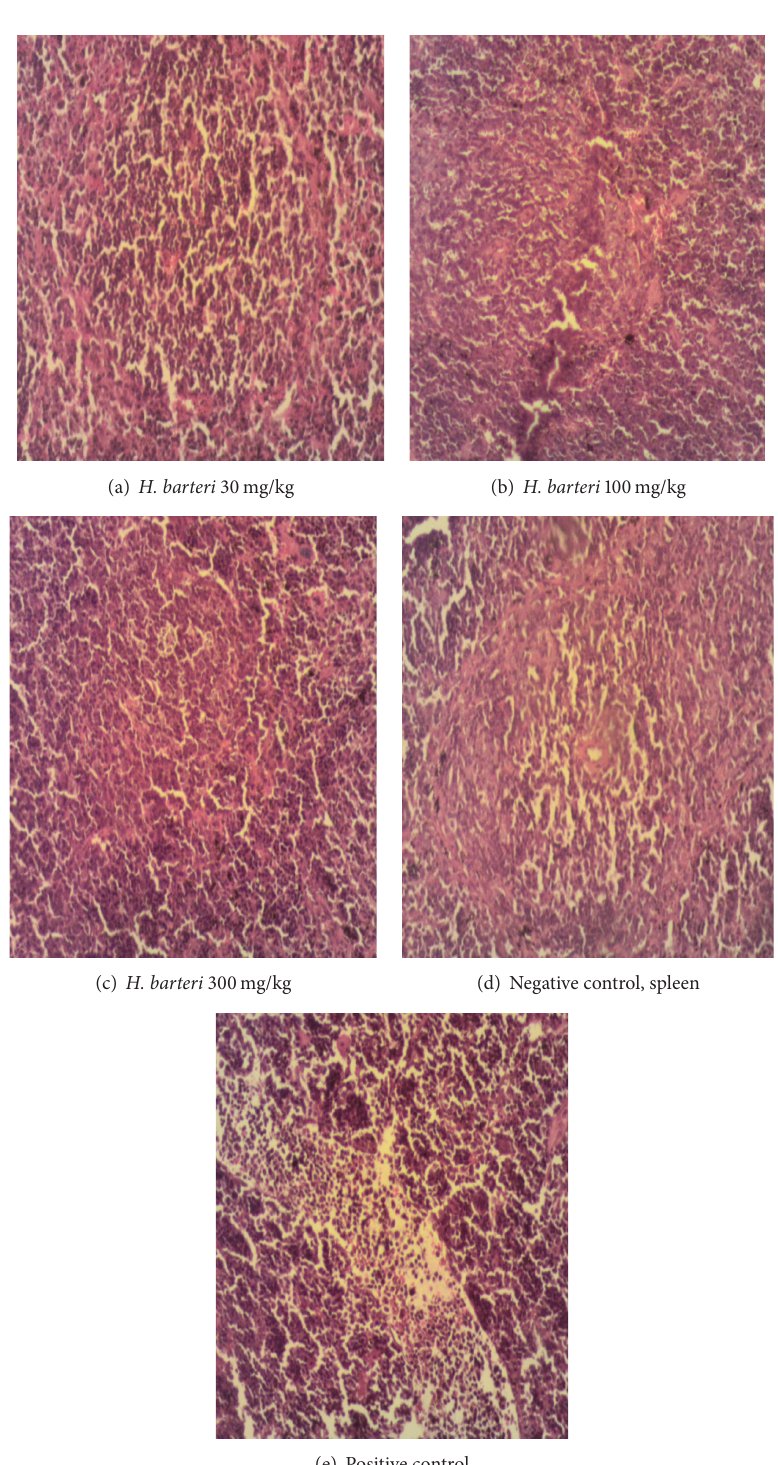
Figure 4: Sections of spleen under high magnification (100x). (a) H. barteri (30mg/kg), extract treated spleen: mild reduction of these pathologies caused by the parasite in the tissues; (b) H. barteri (100mg/kg), extract treated spleen: mild haemosiderosis and loss of cellular architecture; (c) H. barteri (300mg/kg), extract treated spleen: mild haemosiderosis and lymphoid hypoplasia; (d) spleen of negative control: severe haemosiderosis; (e) artemether/lumefantrine treated spleen: mild haemosiderosis and severe megakaryoblast